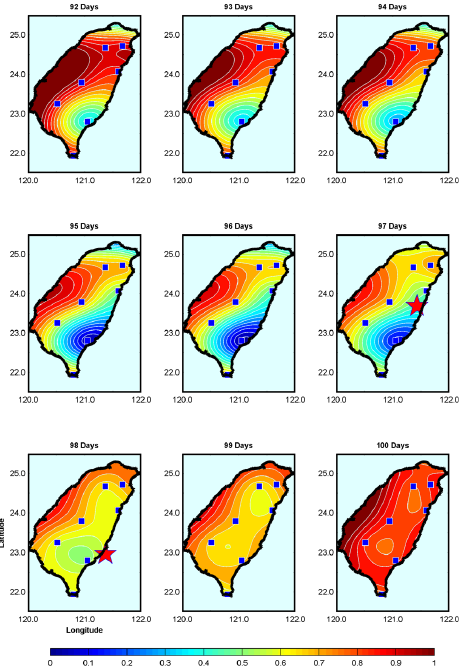
Fig. A1. A contour map of the cross correlation values from nighttime data during EQ2 and EQ3. Blue squares indicate locations of the geomagnetic stations in Taiwan. Red stars represent the epicenter of EQ2 and EQ3. Color lines on Taiwan denote the cross correlation values.